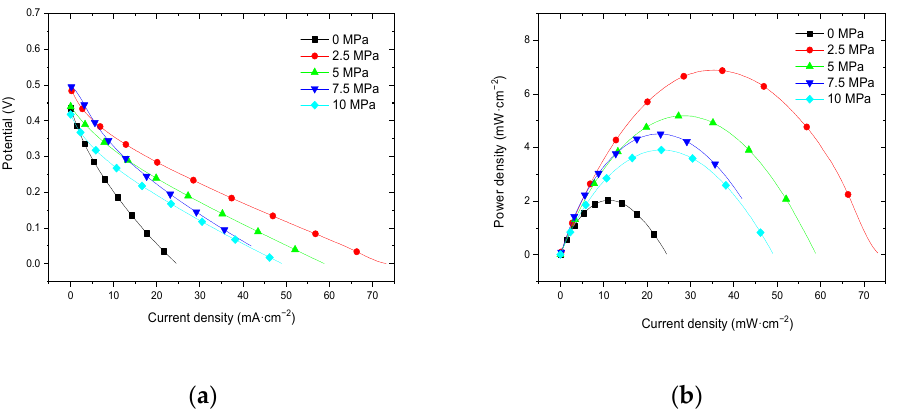
Figure 10. The effect of hot-pressing pressure on the performance of titanium mesh-based MEA at room temperature with an oxygen environment. ( a ) Curve between current density and voltage; ( b ) curve between current density and power density. ( b ) curve between current density and power density.